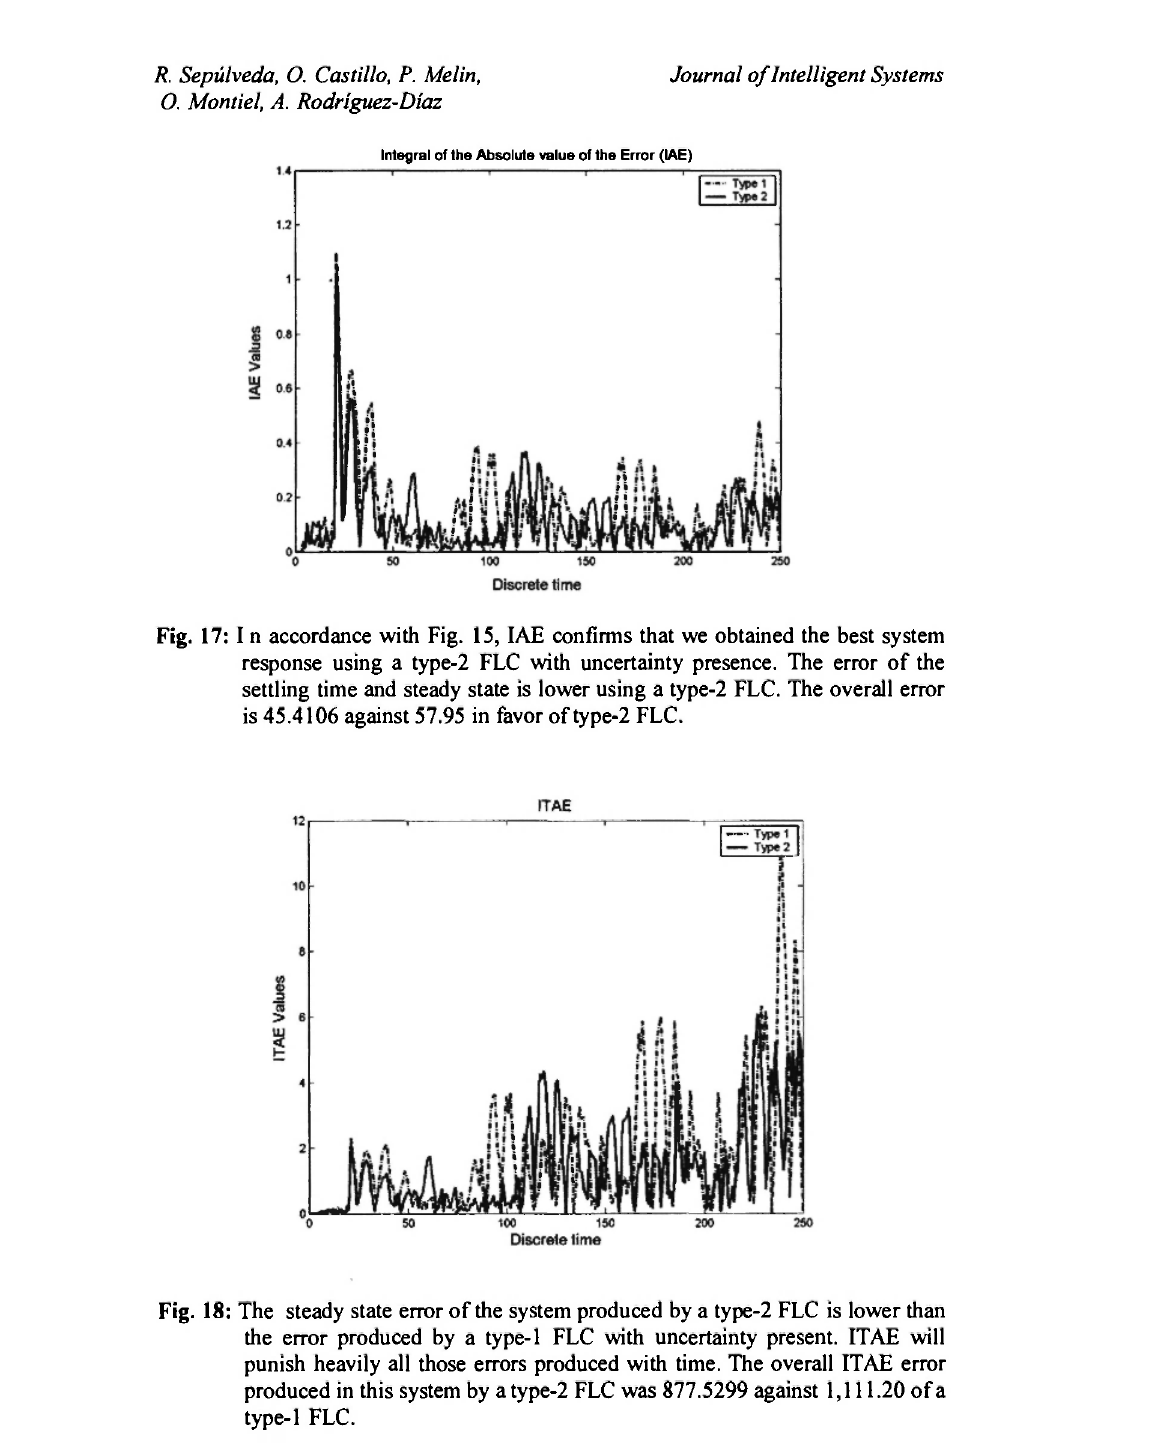
Fig. 18: The steady state error of the system produced by a type-2 FLC is lower than the error produced by a type-1 FLC with uncertainty present. ITAE will punish heavily all those errors produced with time. The overall ITAE error produced in this system by a type-2 FLC was 877.5299 against 1,111.20 of a type-1